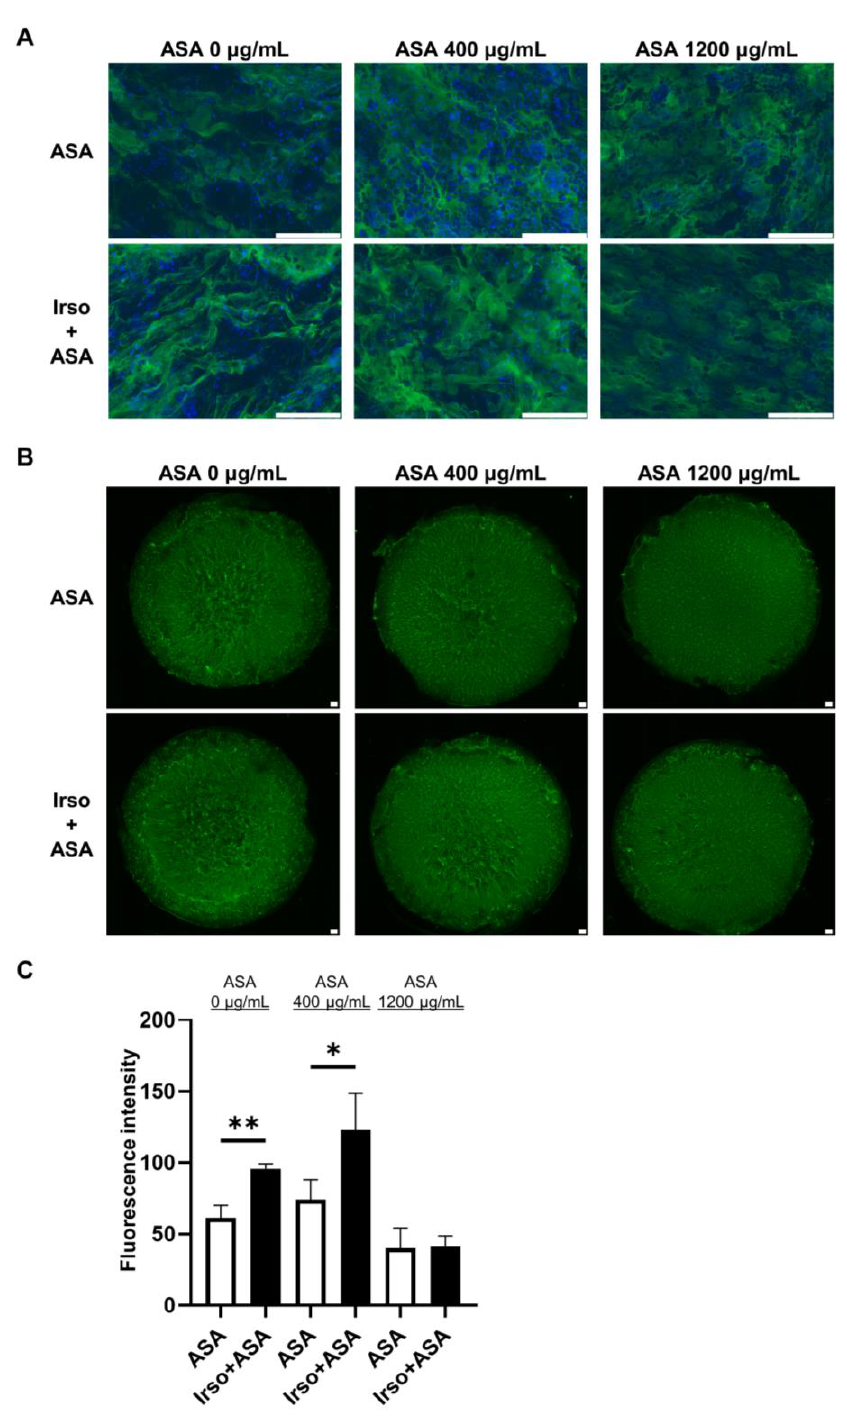
Figure 6. MUC2 expression in ASA-injured 2D-hiPSC-SI after Irsogladine administration. ( A ) Im- munofluorescence staining for MUC2 (green). Upper panels, ASA group; lower panels, Irso + ASA group. Nuclei were counterstained with DAPI (blue). Scale bars, 100 µ m. ( B ) Representative images of immunofluorescence staining for MUC2 (green) based on fluorescence intensity. Upper panels, ASA group; lower panels, Irso + ASA group. Scale bars, 100 µm. ( C ) Comparison of MUC2 fluores- cence intensity between the ASA group and Irso + ASA group. MUC2 fluorescence intensity was calculated in arbitrary units based on threshold color using ImageJ software. Data were obtained from 3 independent sections in each sample. Mean ± SD; n = 3. Statistical analysis was performed using two-tailed Student ’ s t -test; * p < 0.05, ** p < 0.01. ASA; acetylsalicylic acid, Irso; Irsogladine.